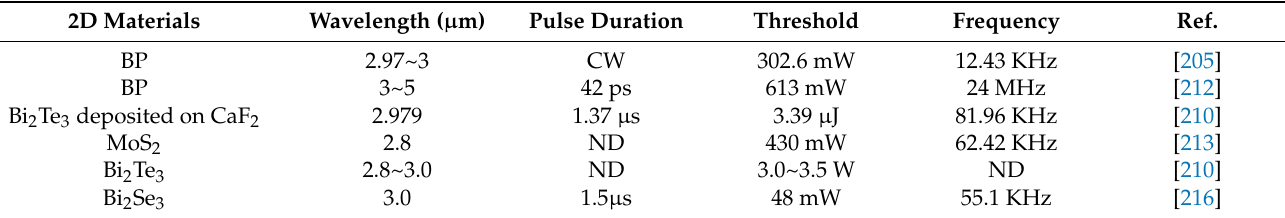
Table 3. The laser operation based on 2D